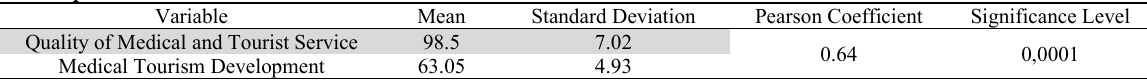
Significant relationship test between quality of medical and tourist services and medical tourism